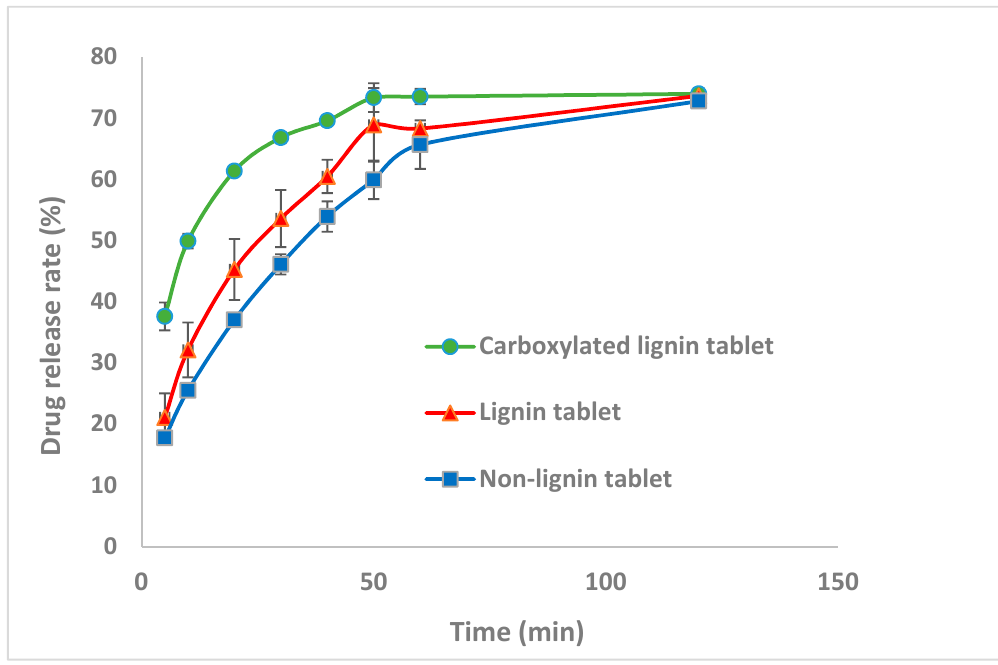
Figure 5. Drug release rate of paracetamol for the formulations at pH = 5.8.